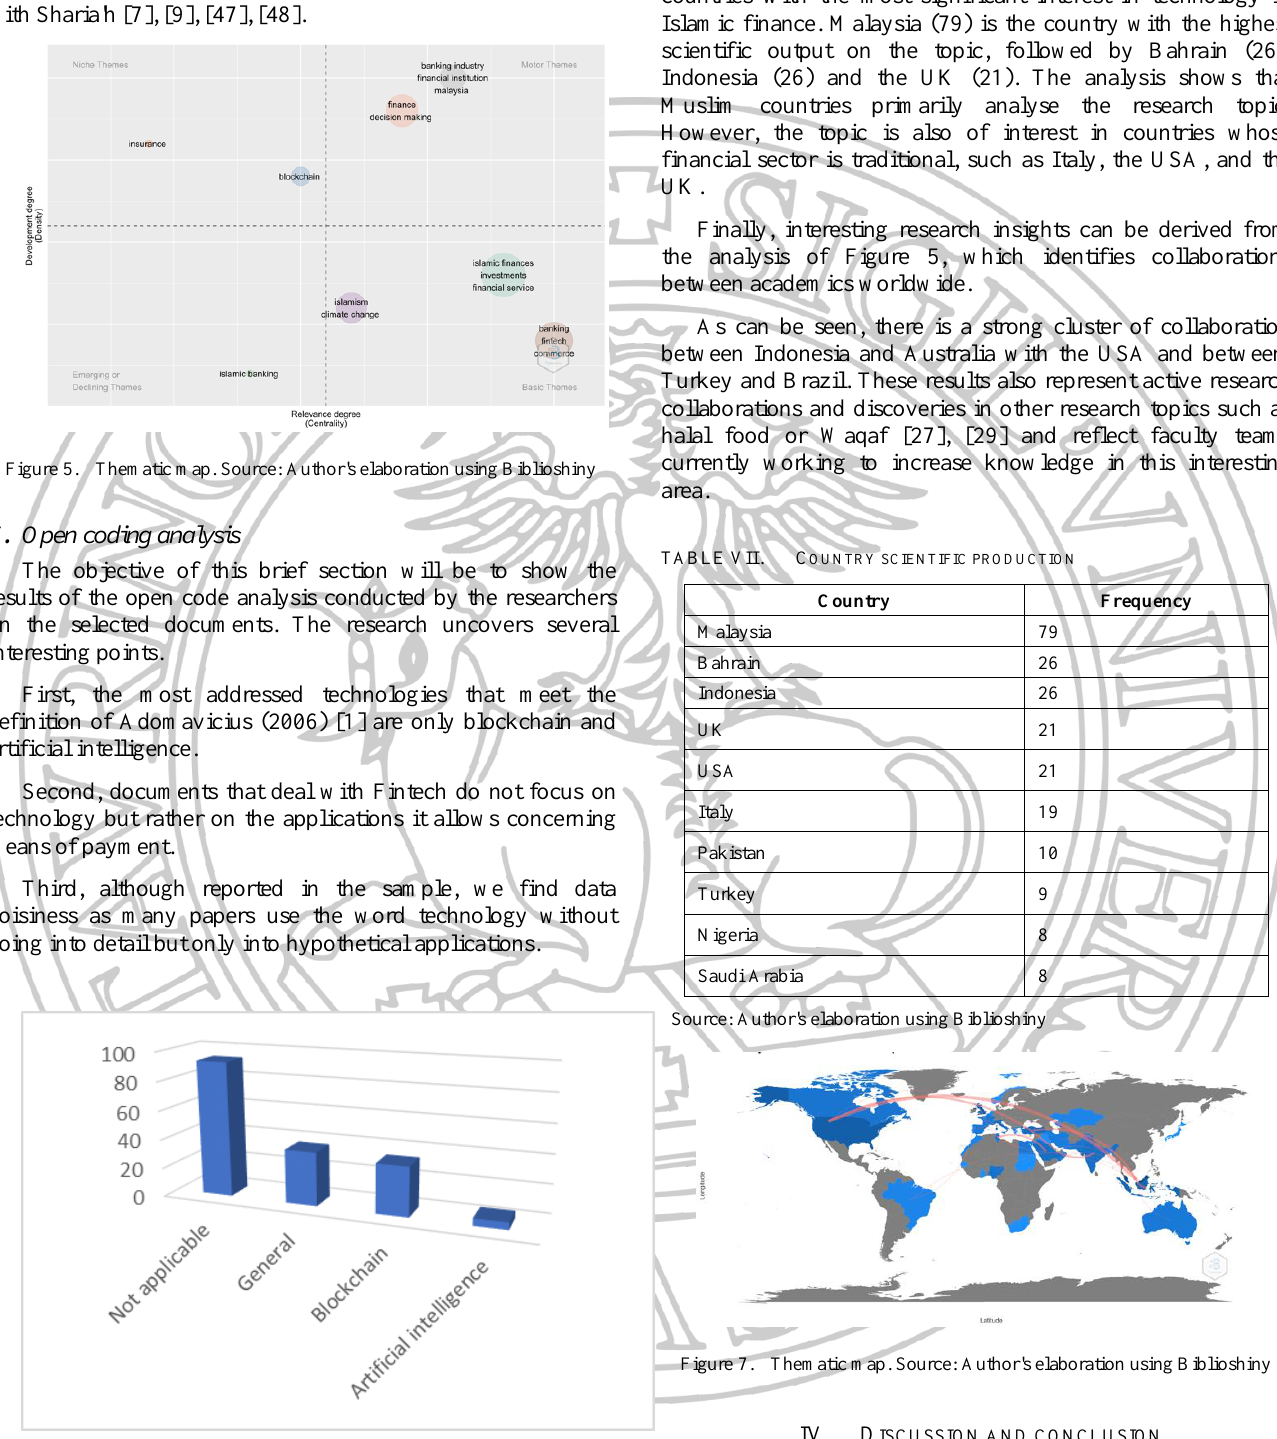
Figure 7. Thematic map. Source: Author's elaboration using